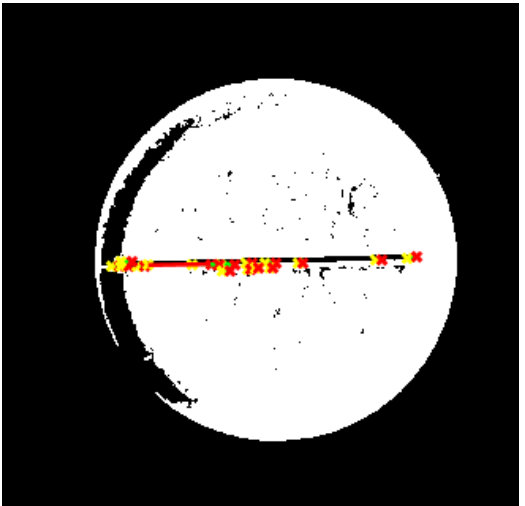
Figure 4. The outcome of the line detection on the pill surface.